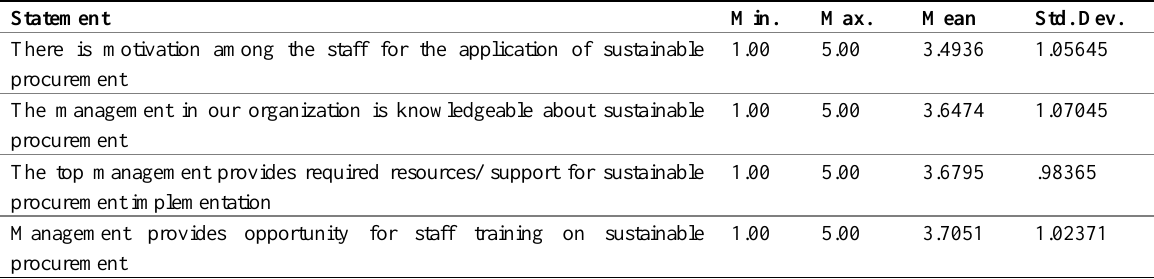
Table 5: Effect of Management Support on Sustainable